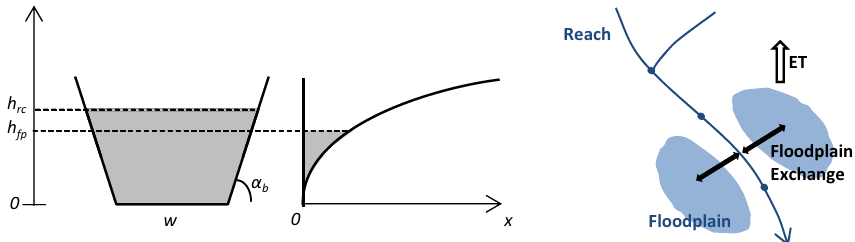
Fig. 2. Cross section of reach and floodplain (a symmetrical floodplain is located to the left of the reach) and illustration of river network– floodplain